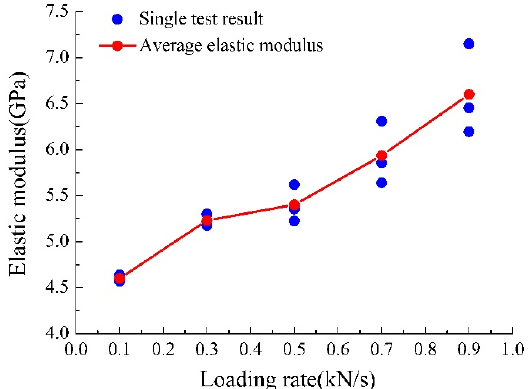
Figure 6. Yellow sandstone’s elasticity modulus under different loading rates.